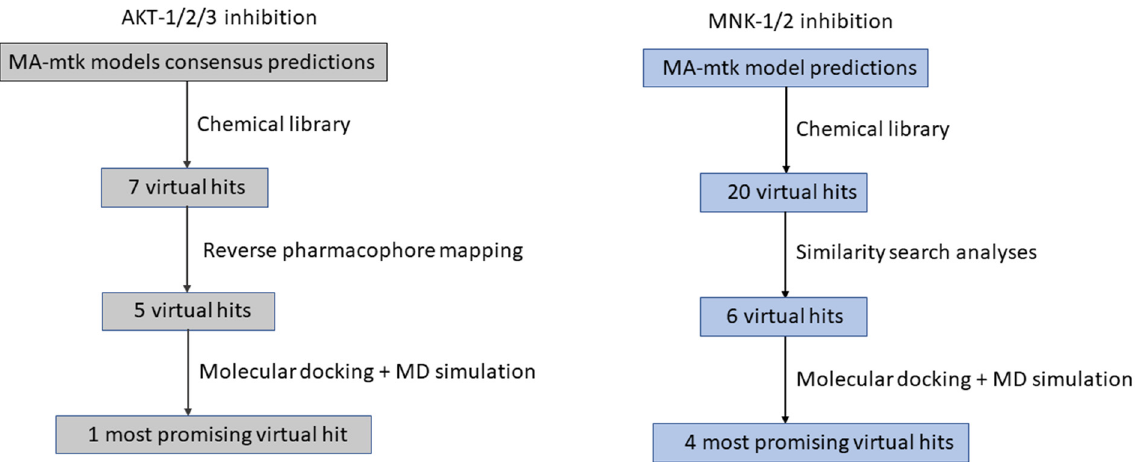
Figure 3. The virtual screening strategy adopted for the design of pan-AKT inhibition ( left ) and pan-MNK inhibition ( right ) [25].